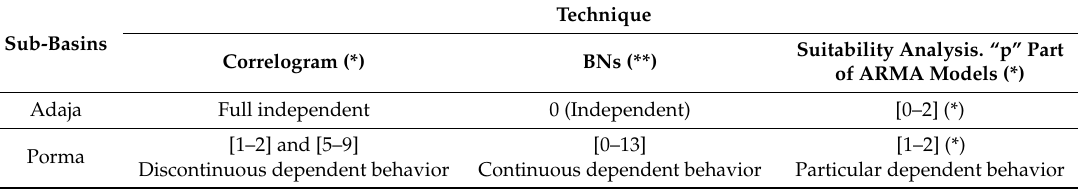
Table 3. Comparison of time order suitability analysis from applied techniques. (*) Static (**)